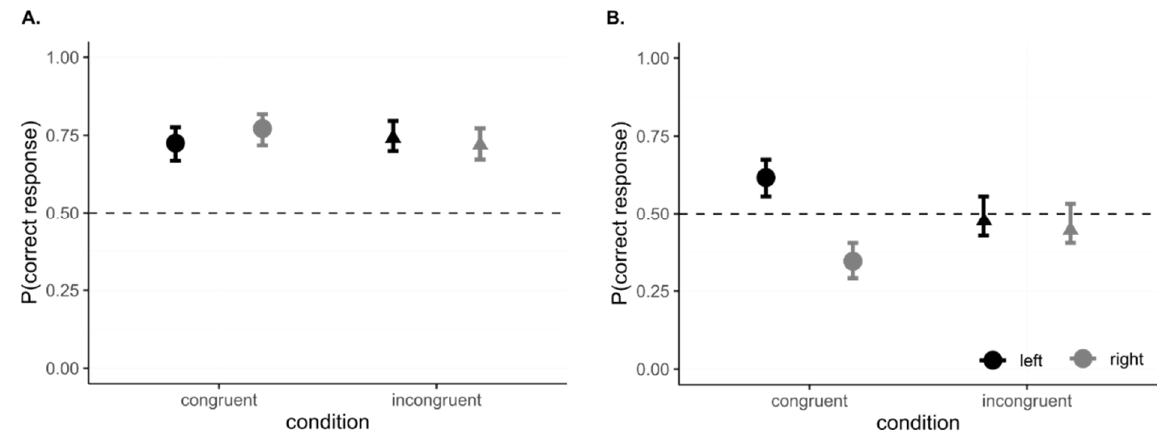
Figure 7. Results of the side bias analysis in Experiment 3: ( A ). Acquisition. Chicks perform equally well in both the congruent and incongruent conditions (on the x axis), irrespective of the spatial position of the correct box. ( B ). Reversal. Chicks’ performance in the congruent condition is affected by a spatial bias, for which subjects tend to respond correctly to the left hemispace but not to the right one. In the incongruent condition, however, chicks do not exhibit such a spatial bias, and chicks performed at chance level irrespective of the spatial position of the correct box. In light gray, chicks’ performance when the correct response must be provided in the right hemispace, in black, chicks’ performance when the correct response must be provided in the left one.